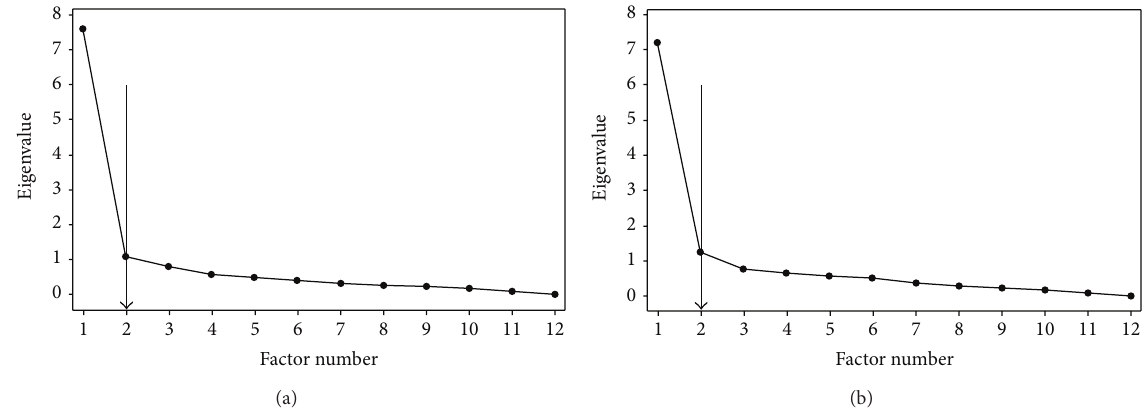
Figure 2: (a) Scree plot showing eigenvalues in response to the number of components for the estimated variables of wheat under inoculation condition and different water levels. (b) Scree plot showing eigenvalues in response to the number of components for the estimated variables of wheat under noninoculatin condition and different water